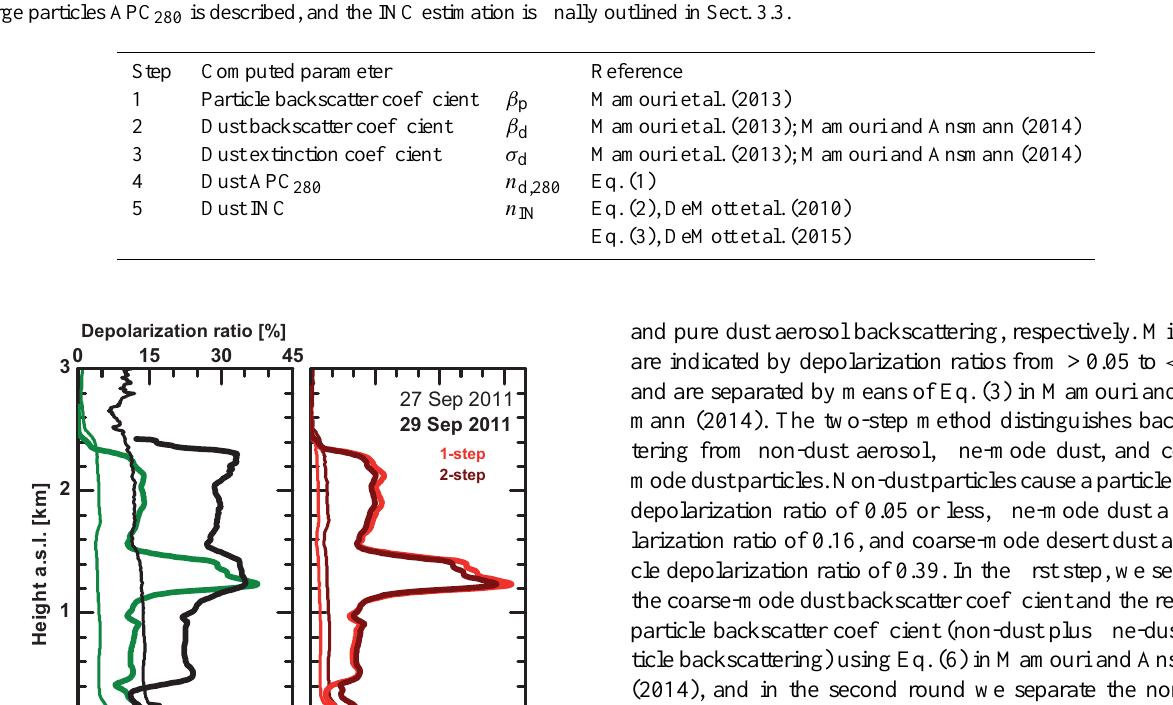
Table 1. The five steps required to obtain the dust-related INC profile from the profile of the particle backscatter coefficient β p measured with polarization lidar. The determination of β d and σ d is explained in Sect. 3.1. In Sect. 3.2, the retrieval of the number concentration of large particles APC 280 is described, and the INC estimation is finally outlined in Sect. 3.3.